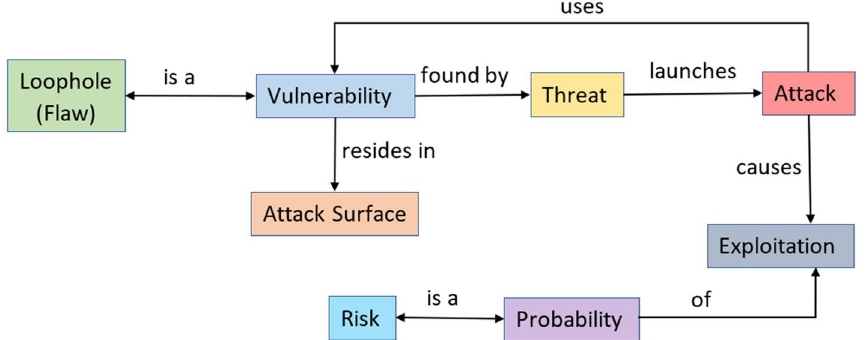
Figure 2. Relationship between basic terms used in